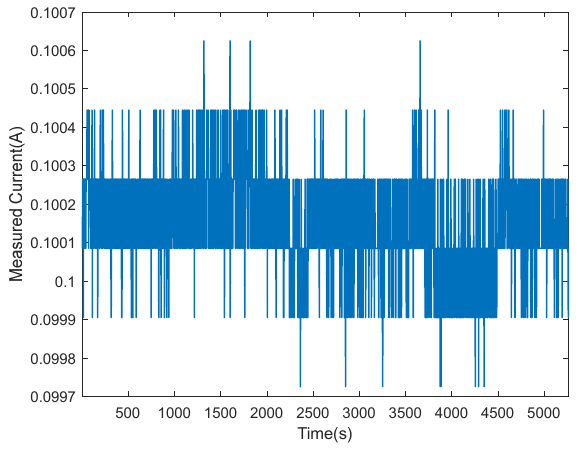
Figure 7. Measured current during low-current charging.